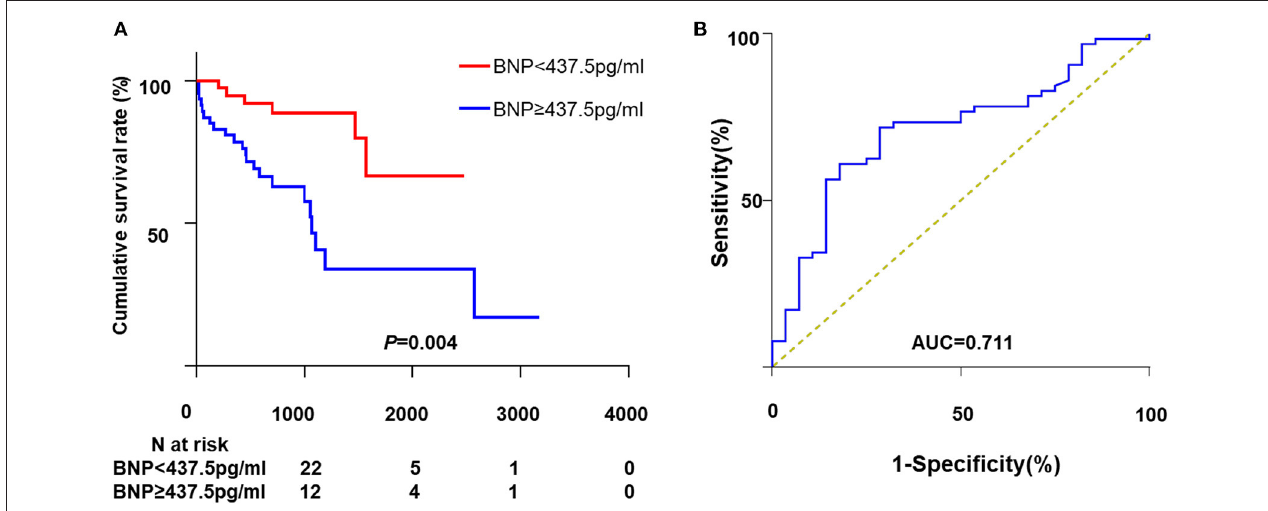
FIGURE 2 | The association between BNP and all-cause mortality. (A) Kaplan-Meier curve analysis. (B) The ROC curve of BNP for all-cause mortality. ROC, receiver operating characteristic; BNP, brain natriuretic peptide; AUC, area under curve.